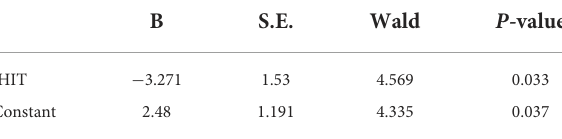
TABLE 5 Results of the binary logistic regression with falls during the last year as the dependent variable (dichotomous: YES/NO); fHIT score as